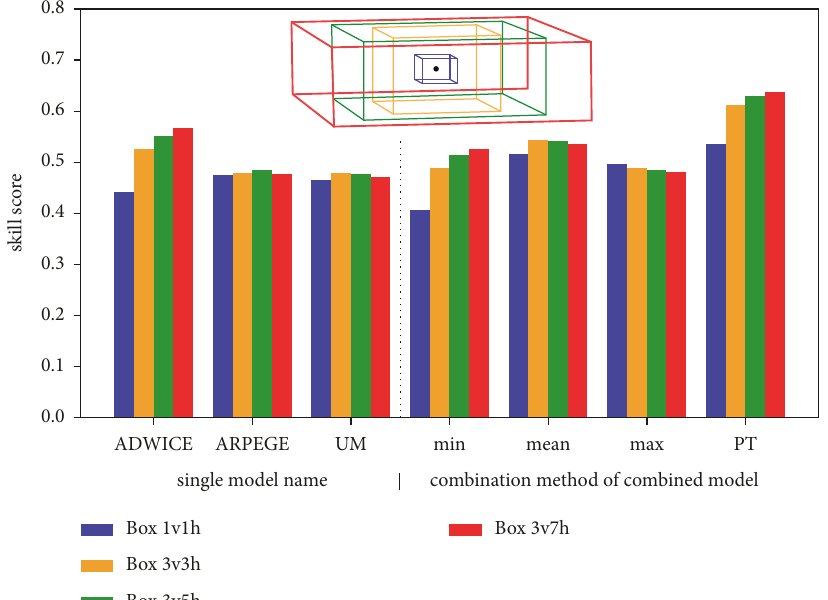
Figure 7: Multicategory average skill score (MCASS) comparison of the three individual forecast products with the four combination methods. The colors mark the box sizes used around the PIREPs to extract the forecast value and are shown schematically on top of the